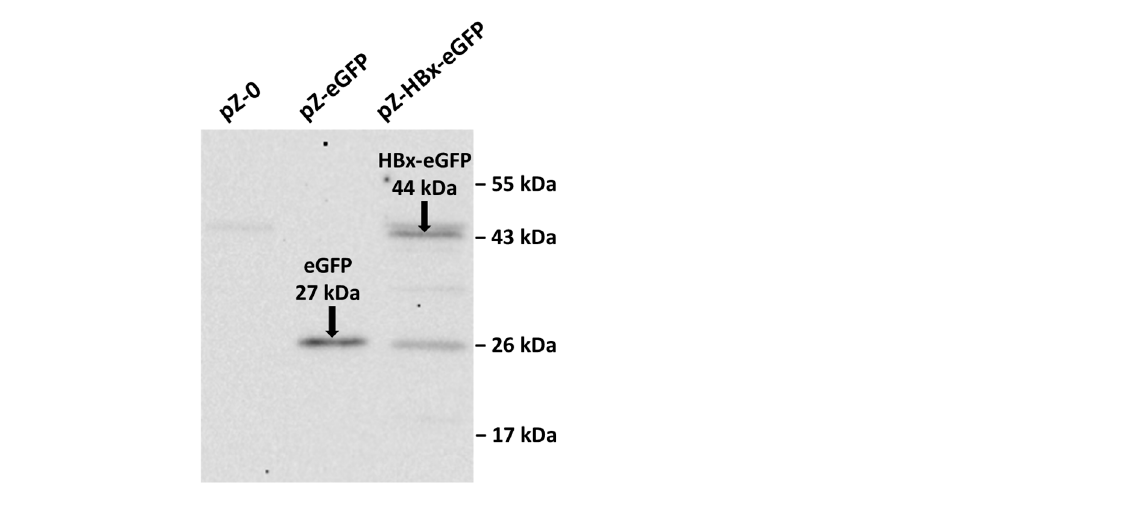
Figure 1. Western blot analysis of eGFP fusion proteins from pZ-0, pZ-eGFP, and pZ-HBx-eGFP strains of Y. lipolytica . The eGFP and HBx-eGFP signals are indicated by arrows. On the right, the molecular weights of the markers are shown.